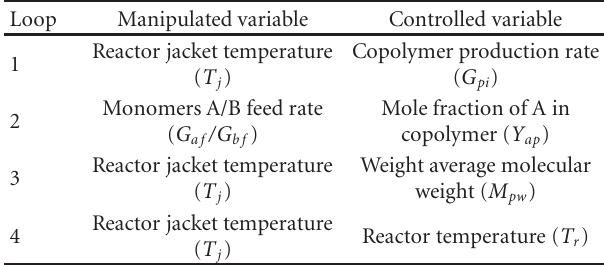
Table 2: SISO control loops.